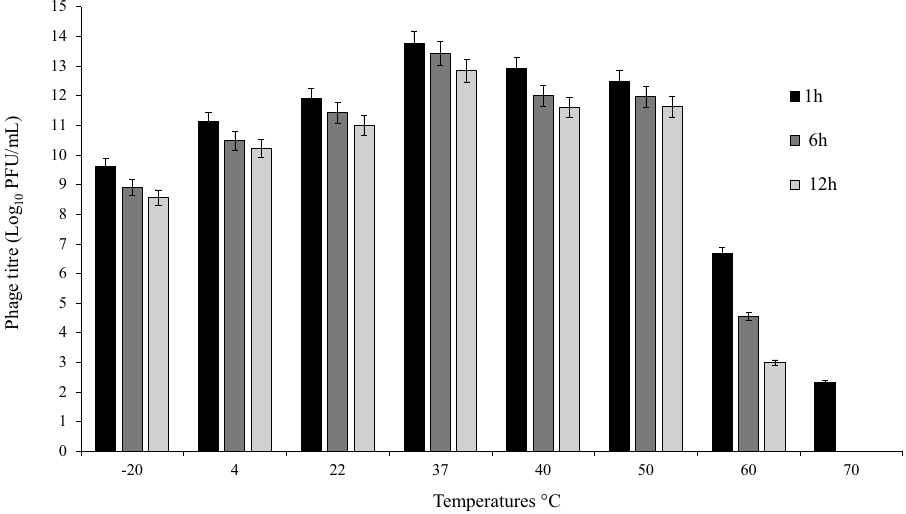
Figure 4. Stability of vB_EfaS-SRH2 phage at different temperatures (− 20 to 70 °C). The results are presented as the mean ± SD. Error bars indicate the standard deviation.